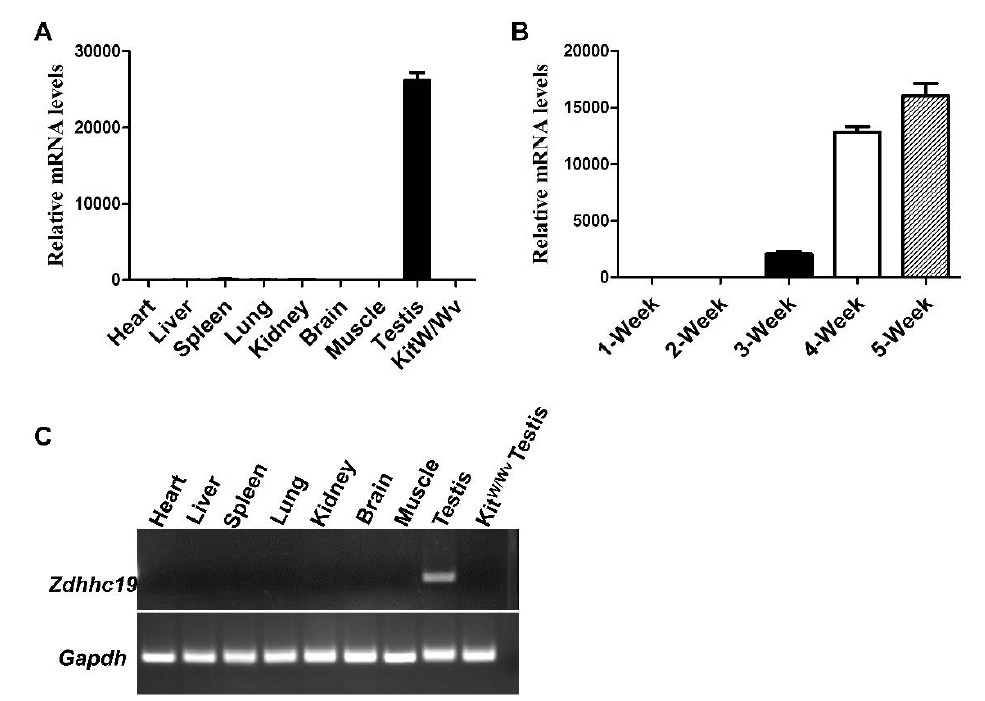
Figure 1. Zdhhc19 is highly expressed in testicular germ cells but not in other tissues. ( A ) qPCR analyses of Zdhhc19 mRNA expression levels in eight different organs from wildtype adult mice and Sertoli cells ( Kit W/Wv testis). ( B ) qPCR analyses of Zdhhc19 mRNA expression levels in developing testes at 1-, 2-, 3-, 4-, and 5-week. ( A , B ) Zdhhc19 mRNA expression level in heart ( A ) and 1-Week ( B ) were used as baseline control, Gapdh served as the cDNA loading control. Data are presented as mean ± SEM. ( C ) RT-PCR analysis showed that Zdhhc19 mRNA was only detectable in the testis. No signal was detected in the other eight tissues.